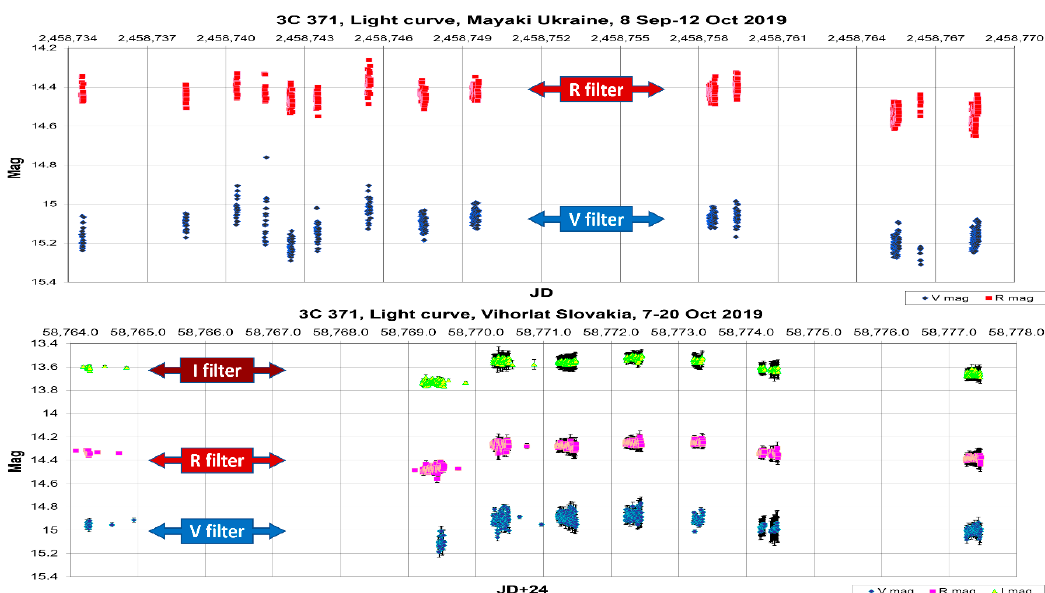
Figure 9. Light curves of 3C 371, obtained in Ukraine ( upper graph ) and Slovakia ( lower graph ). The flags indicate the V, R, I bands for the individual light curves.